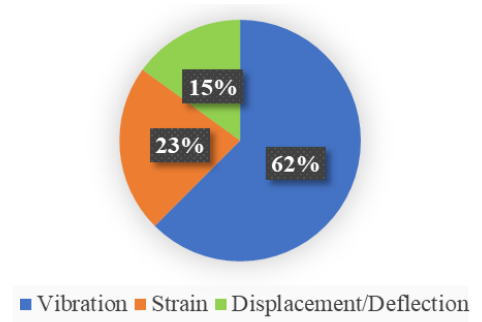
Figure 1. Types of monitoring data used in model-based SHM of long-span cable-stayed bridges (based on 40 reputable journal papers collected from literature since 2015).